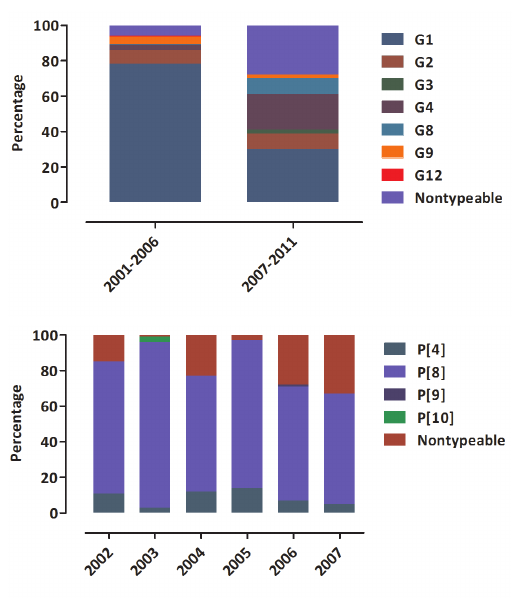
Figure 3. Prevalence of Rotavirus in Iran: (A) G Genotypes in 2001-2006 and 2007-2011; (B) P Genotypes in 2001-2002, 2003-2004, 2004-2005, 2005-2006, 2006-2007 and